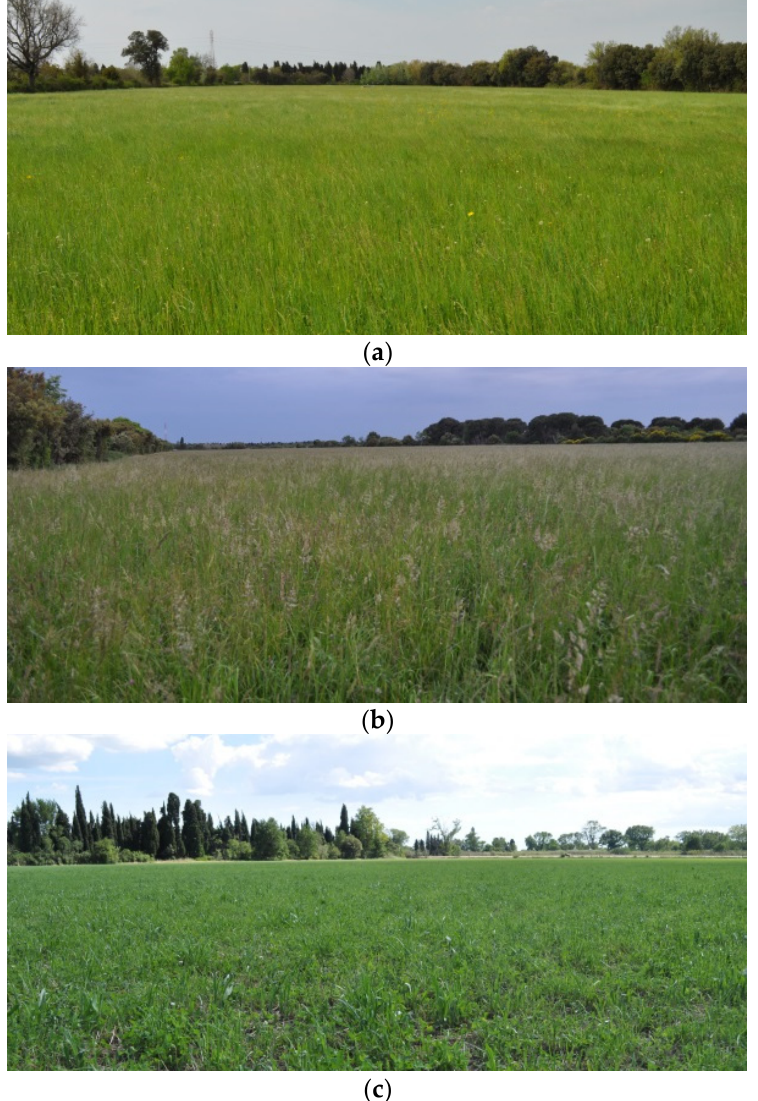
Figure 3. Representative examples of actual vegetation during the first and second crop cycles. ( a ) Moderately developed coarse hay (cycle I), ( b ) well-developed coarse hay (cycle I), and ( c ) unde- veloped legume grass (cycle II).